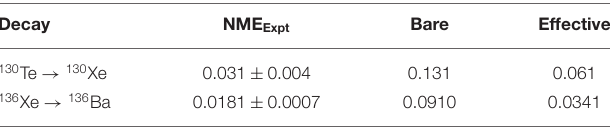
TABLE 1 | Experimental [109] and calculated NMEs (in MeV − 1 ) of the 2 νββ decay for 130 Te and 136 Xe. Decay NME Expt Bare Effective 130 Te → 130